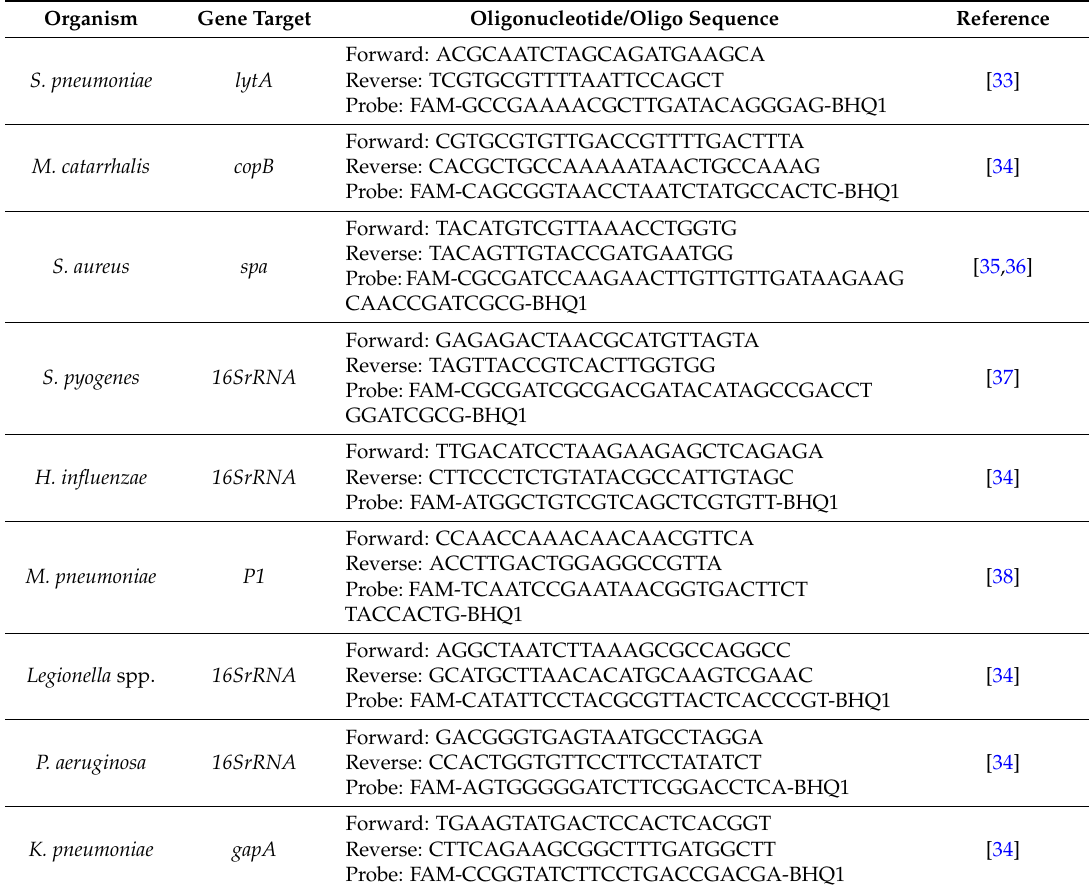
Table 3. Real-time PCR assays for detection of nine respiratory